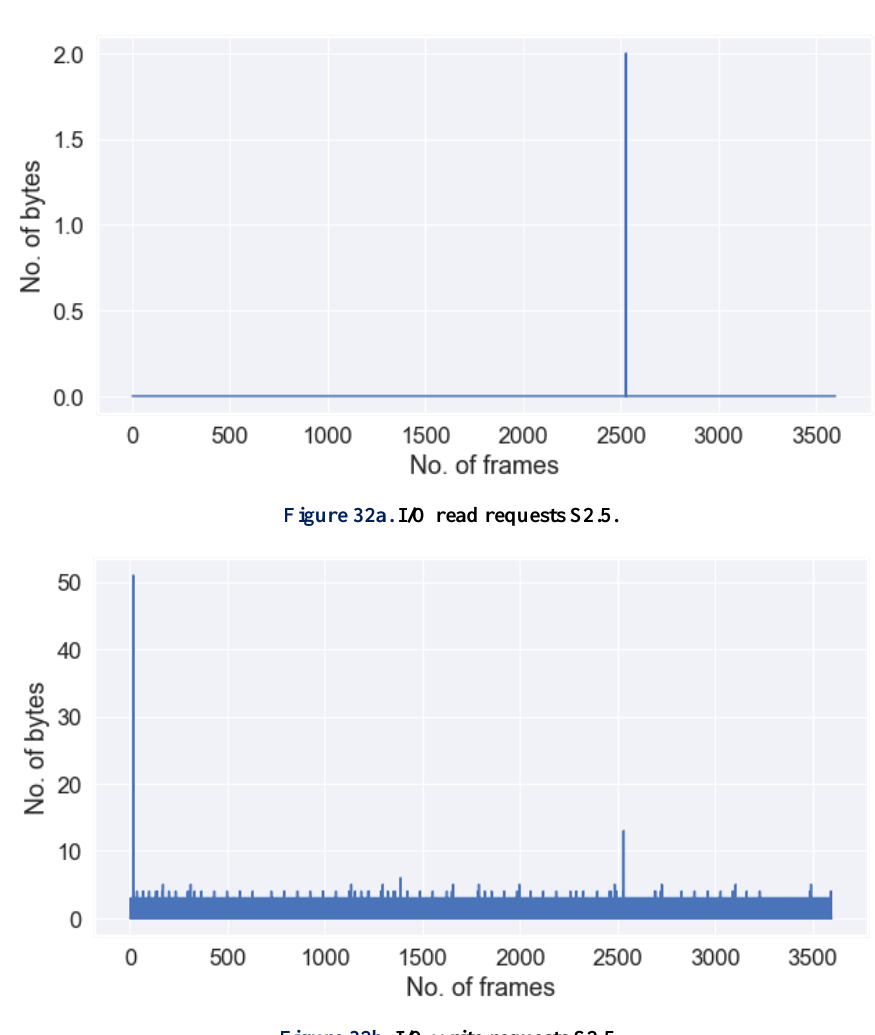
Figure 32b. I/O write requests S2.5.